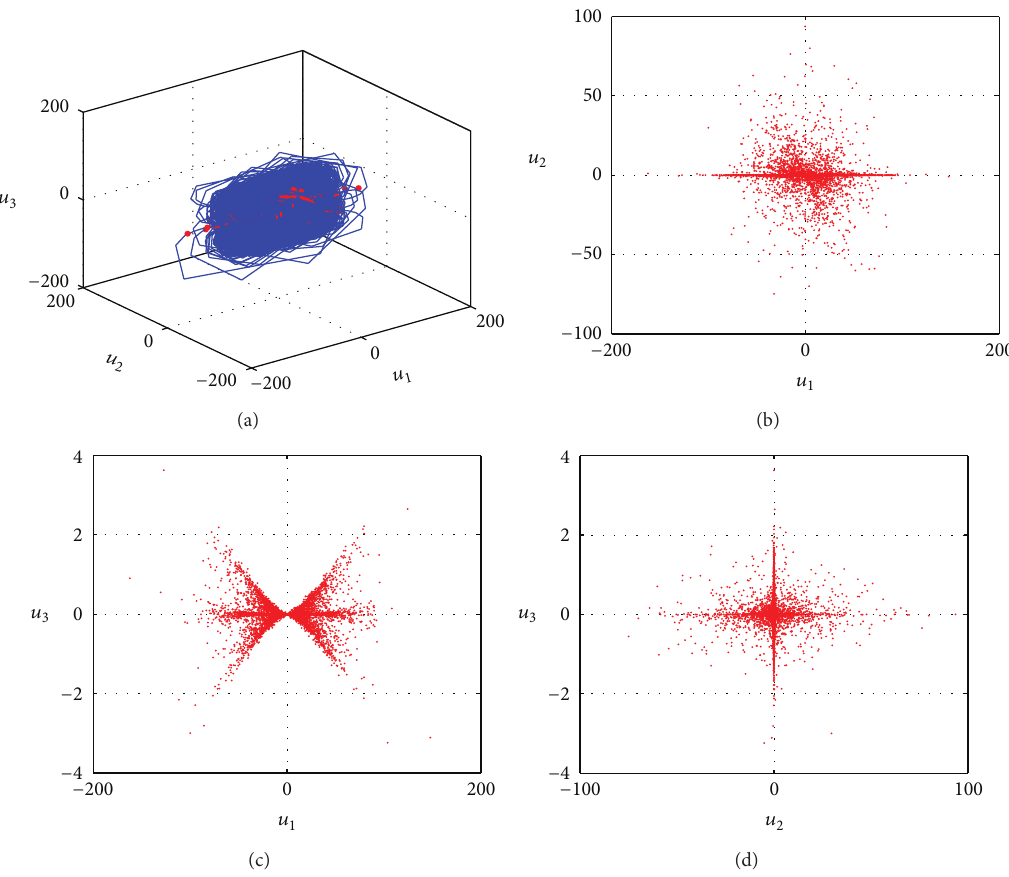
Figure 5: Projections of Poincar´e maps of the four-wing hyperchaotic attractors of complex Dadras system (5) with parameters 𝑎 = 10 , 𝑏 = 40 , and 𝑐 = 14.9 , on different crossing sections: 𝑢